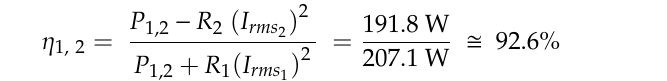
Figure 17. Power transfer boundaries in the simplified schematic of the implemented circuit.